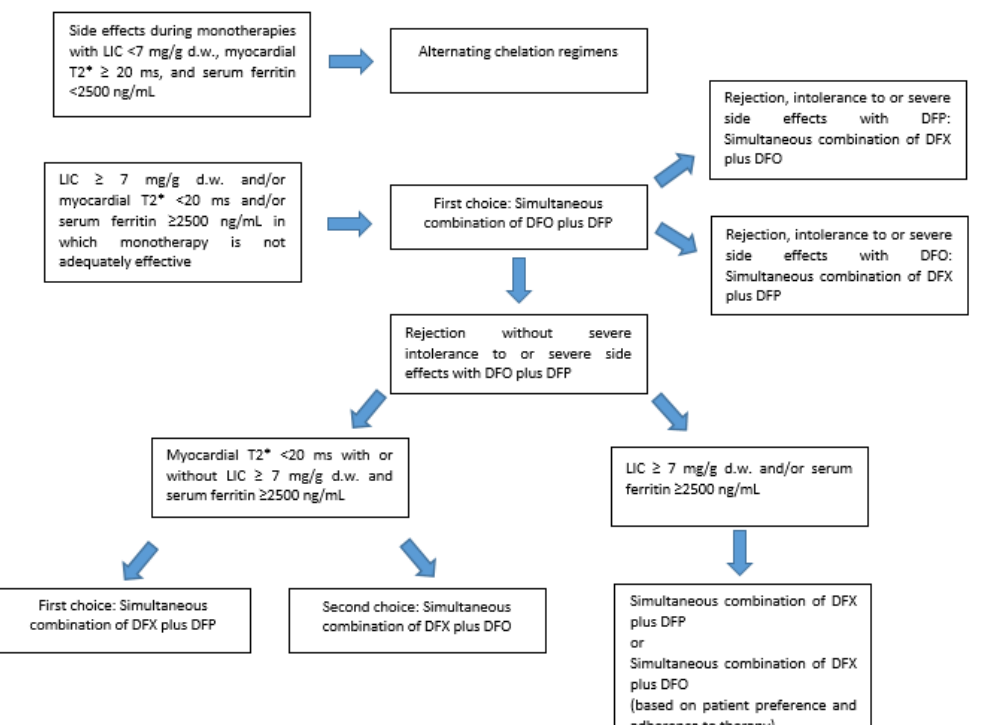
Figure 2. Proposed treatment algorithm for patients with transfusion-dependent thalassemia with persistent or increasing iron overload in which monotherapy is not adequately effective. DFX: deferasirox; DFO: desferrioxamine; DFP: deferiprone; LIC: liver iron concentration.